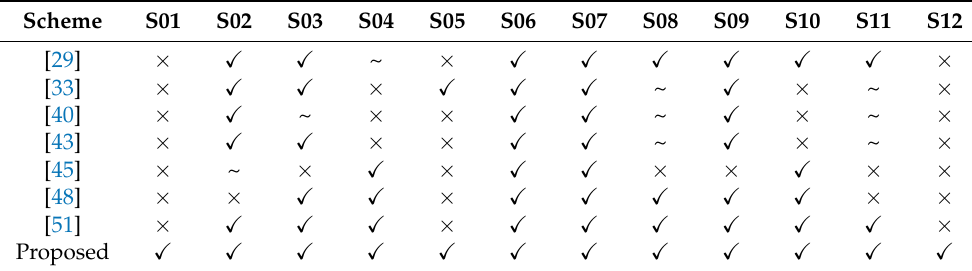
Table 2. A security requirements